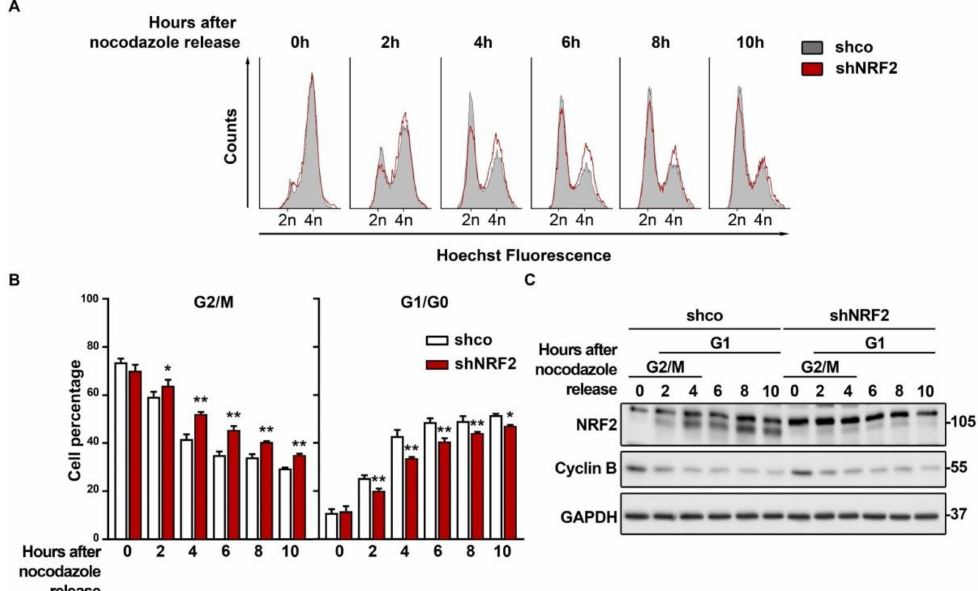
Figure 5. NRF2 absence delays M phase exit. U–373 MG cells were transduced with lentiviral vectors containing shcontrol (shco) or shNRF2–1 (shNRF2). Cells were then synchronized in the M